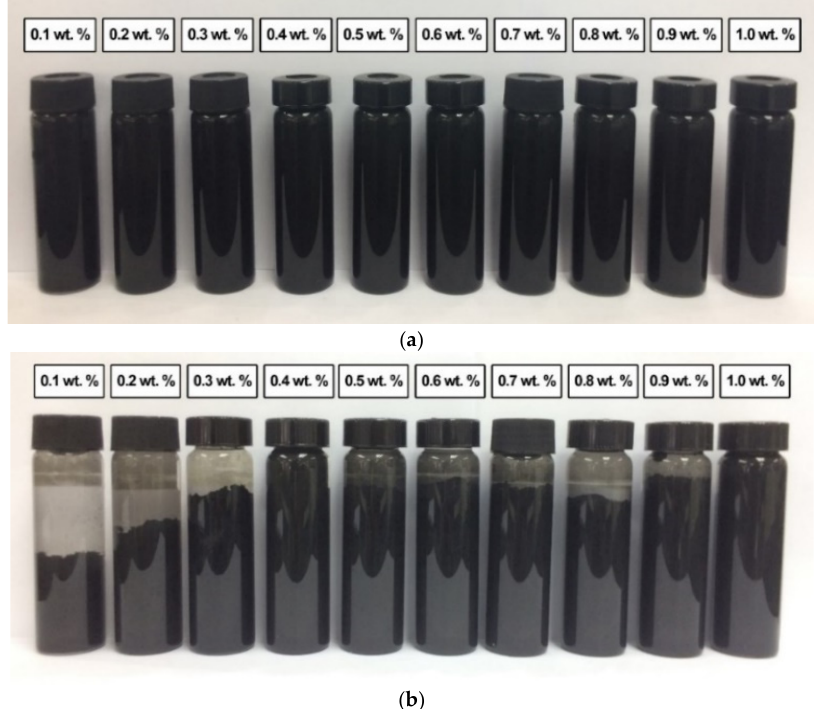
Figure 11. The sedimentation of various commercial CNF-based nanofluids without PVP after ( a ) 0.5 h and ( b ) 100 h of the homogenisation and sonication process.